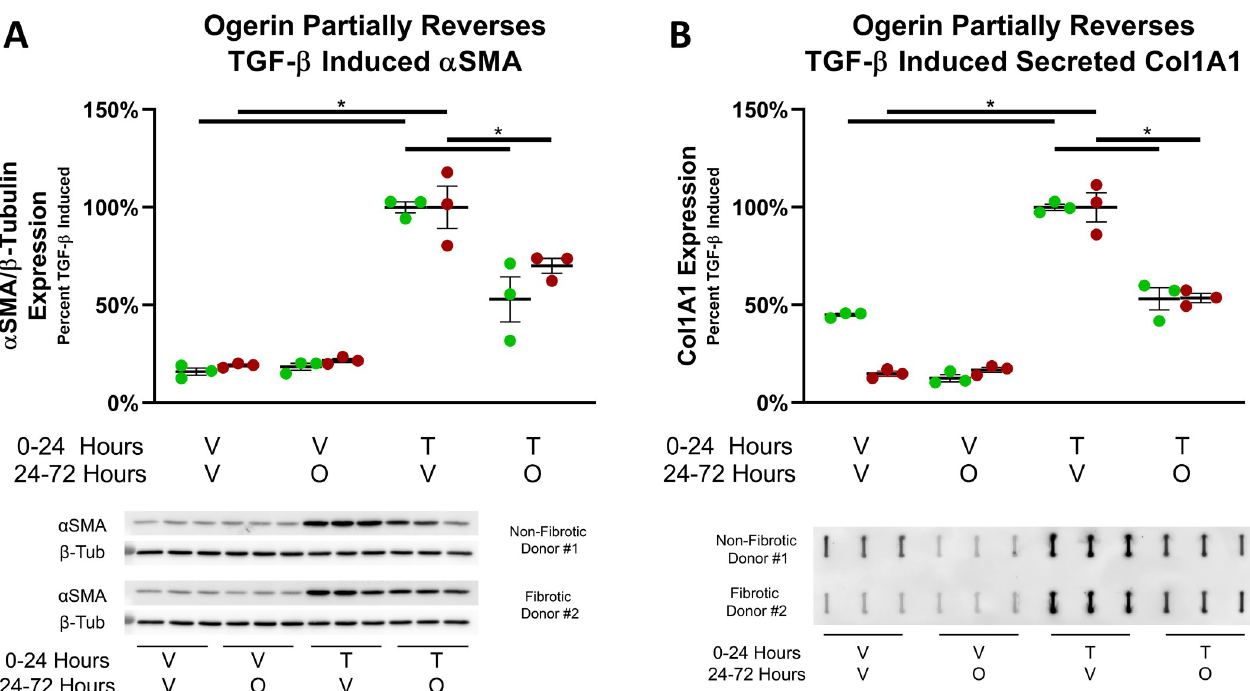
Fig 3. Ogerin partially reverses an established, TGF- β induced myofibroblast phenotype in primary human lung fibroblasts. Primary human lung fibroblasts derived from non-fibrotic or IPF patients were treated +/- 1ng/mL TGF- β (T) or Vehicle (V) for 24 hours. After 24-hour incubation, TGF- β containing media was removed and cells were rinsed with PBS. From 24–72 hours, cells were treated +/- 150 μ M Ogerin (O) or DMSO Vehicle (V). A: Whole cell lysates were analyzed for α SMA expression level via Western Blot. α SMA band expression was standardized to β -Tubulin, expressed as a percent of TGF- β induced. n = 3 per donor per treatment group, dots representative of technical replicates with SEM. � = p < 0.05 by One Way ANOVA with Tukey’s Post-Hoc Test for Multiple Comparisons. B: Cell culture supernatant was analyzed for secreted Col1A1 via slot blot. Band expression was standardized as a percent of TGF- β induced. n = 3 per donor per treatment group, dots representative of technical replicates with SEM. � = p < 0.05 by One-Way ANOVA with Tukey’s Post-Hoc Test for Multiple Comparisons. https://doi.org/10.1371/journal.pone.0271608.g003 PHLFs, Ogerin inhibited TGF- β induced luciferase activity in a dose dependent manner (Fig 5A) further indicating that Ogerin inhibits myofibroblast differentiation through inhibition of TGF- β induced gene transcription.